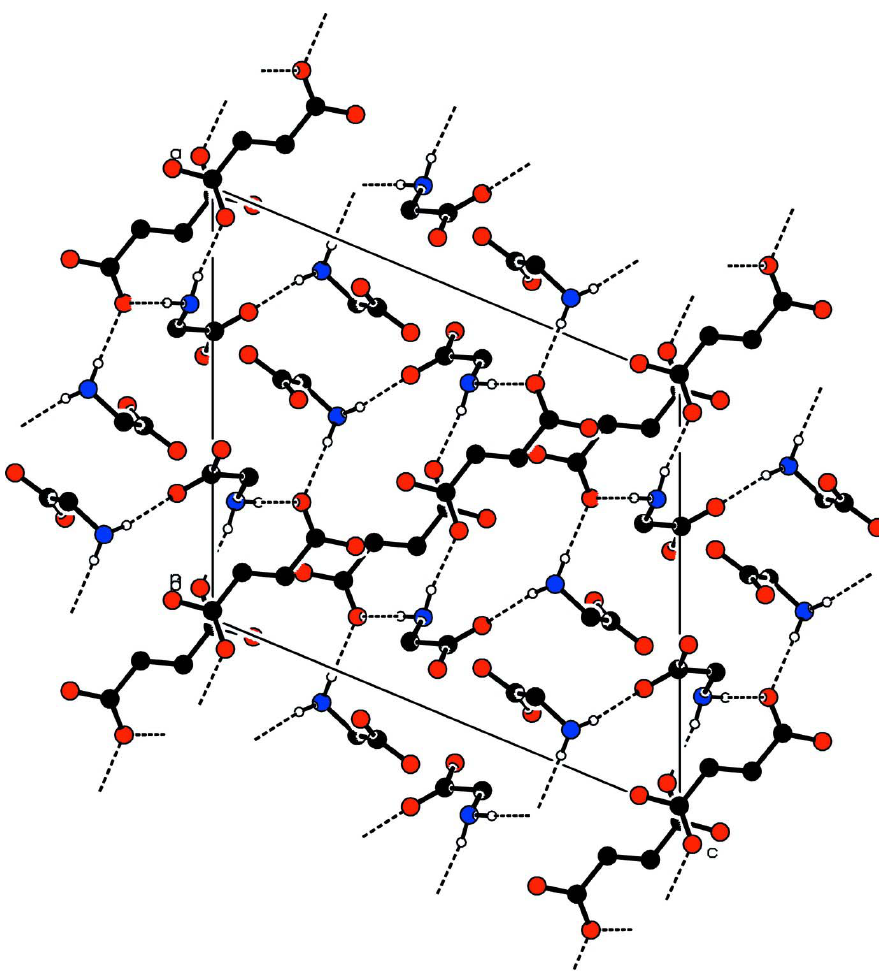
Figure 2 The crystal packing of the molecules down the b